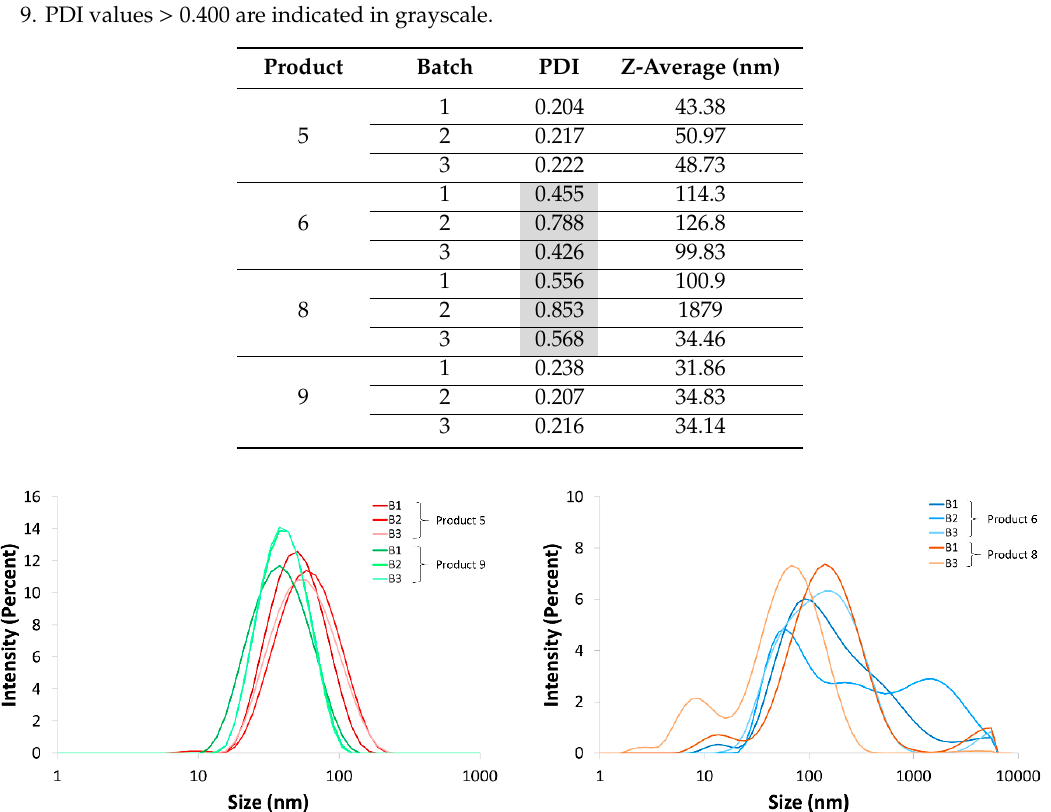
Figure 12. Intensity size distribution of the three different batches of products 5 and 9 (left) and products 6 and 8 (right), excluding batch 2 of product 8, which is represented in Figure S1 (SI section).